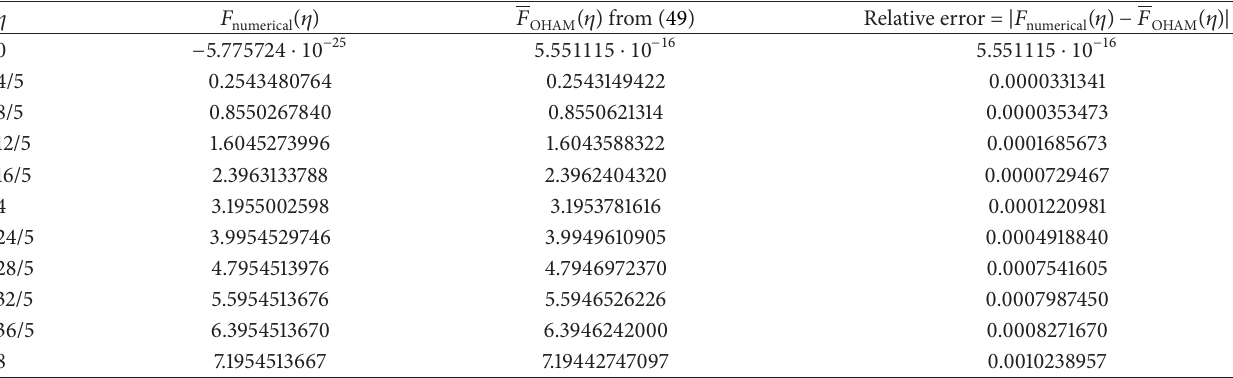
Table 1: Comparison between OHAM results given by (49) and numerical solutions for 𝛽 = 1/2 .